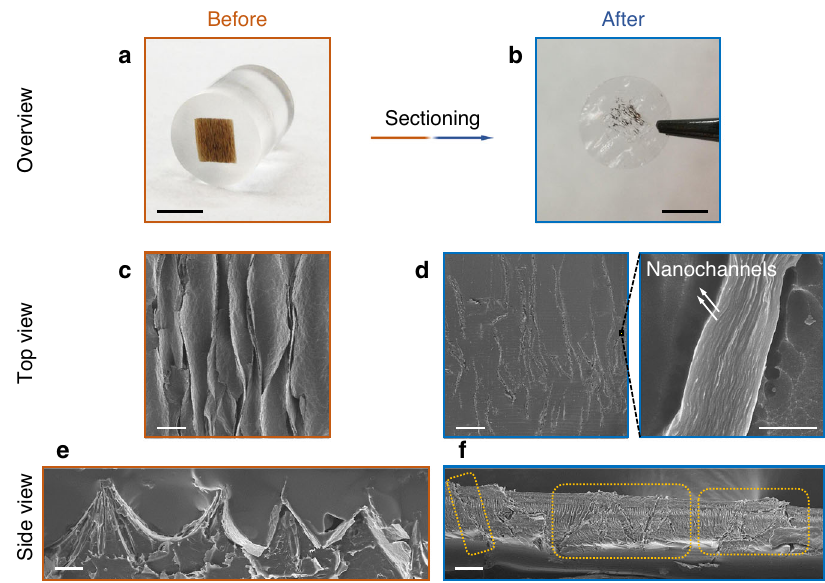
Fig. 2 Morphologies of wrinkled Zr-GO fi lms and VAGME during fabrication. a , b Photographs of wrinkled Zr-GO fi lms imbedded in epoxy matrix and, after thin sectioning, a free-standing VAGME. Scale bar, 4 mm. c , d Top views of wrinkled Zr-GO fi lms and a VAGME. Wrinkled Zr-GO fi lms show corrugated textures. VAGME shows a strip pattern associated with GO fi lm segments whose edges intersect the top surface. Scale bar, 100 μ m. High- magni fi cation view of one Zr-GO strip on the VAGME surface, showing a uniform, close-packed array of nanosheet layers and interlayer nanochannels. Scale bar, 1 μ m. e Side view of wrinkled Zr-GO/epoxy composite, exhibiting regular zig-zag patterns as desired. f Side view of VAGME, showing several individual Zr-GO near-vertical segments after ridge removal by microtome (highlighted). Scale bar, 20 μ